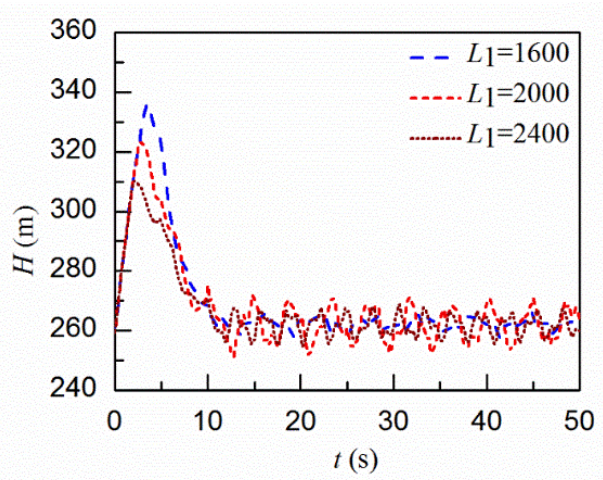
Figure 8. Comparison of the pressure heads at the inlet of the spiral case with different positions of the sand basin.